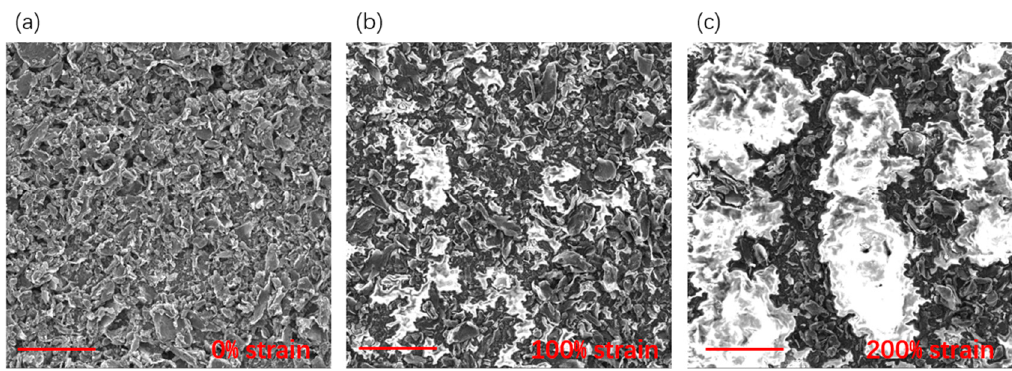
Figure 4. Scanning electron microscopy images of graphene / glycerol sensors without upper-side Ecoflex under 0% ( a ), 100% ( b ) and 200% ( c ) strains, respectively. The scale bars represent 100 µm.